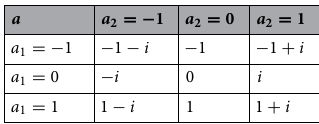
Table 1. Elements of the Galois field GF ( 3 2 ) in the used